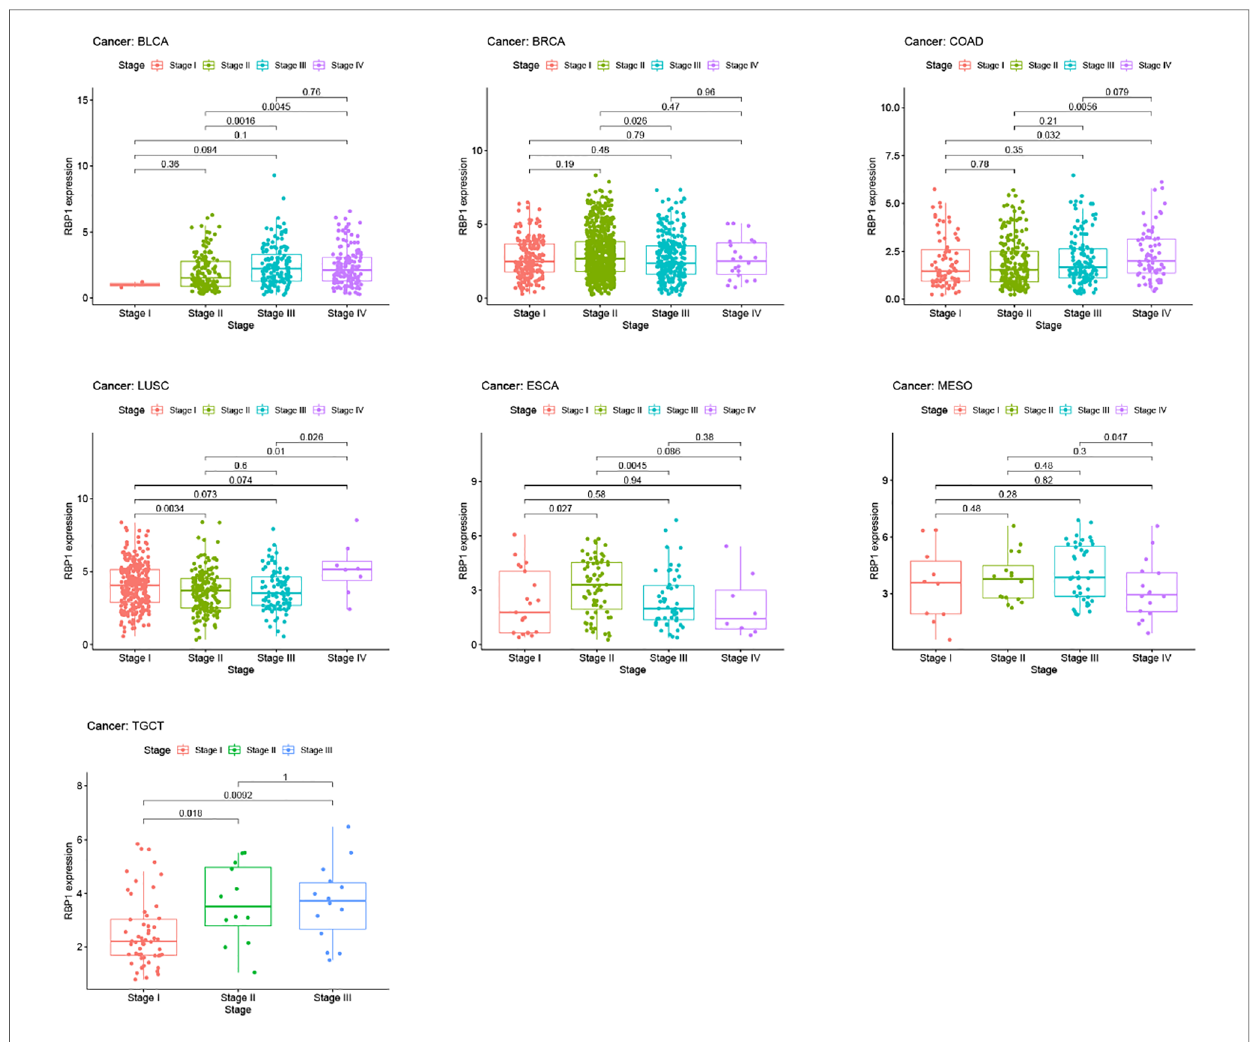
FIGURE 6 Clinical staging analysis of RBP1 in